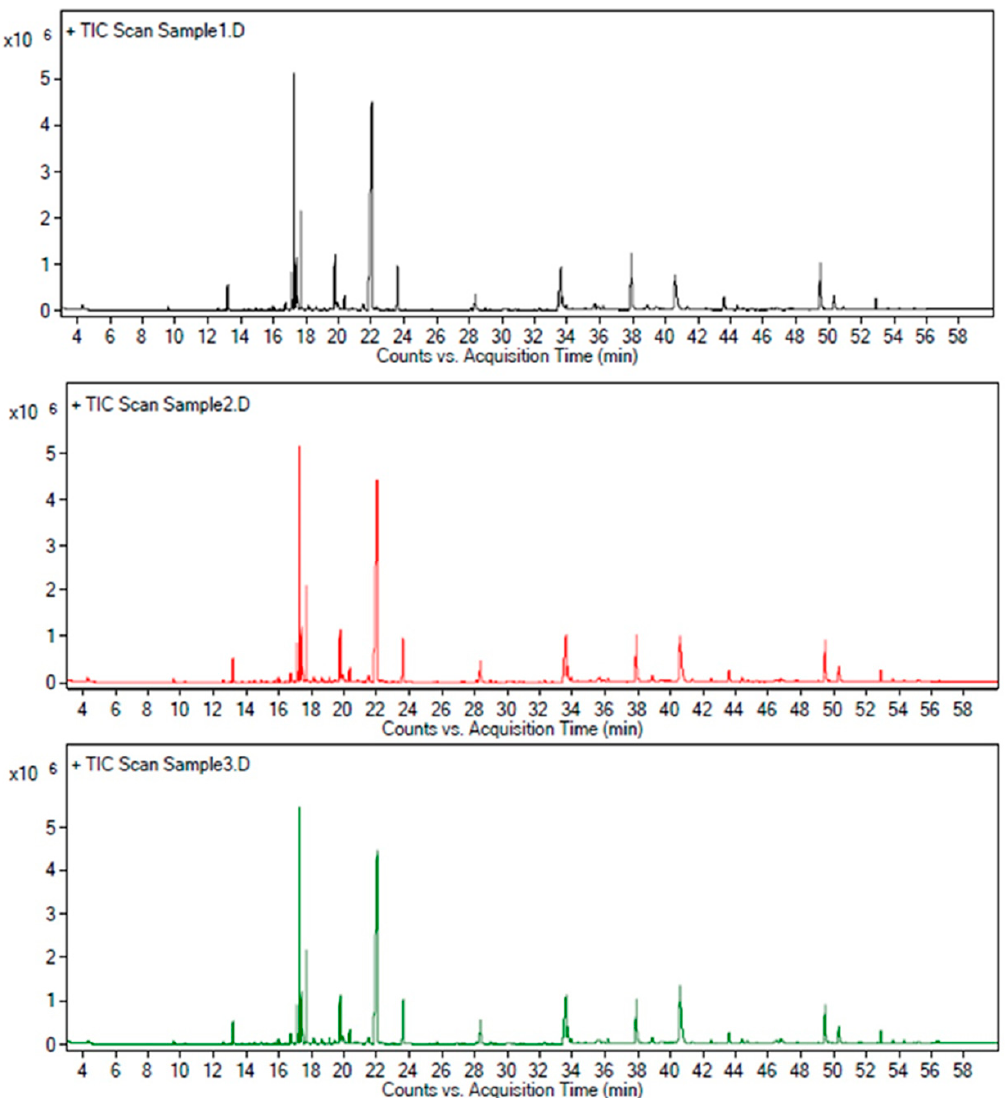
Figure 1. GC / MS total ion chromatogram of three batches of AZ-SFE extracted by optimized Figure 1. GC/MS total ion chromatogram of three batches of AZ-SFE extracted by optimized parameters.